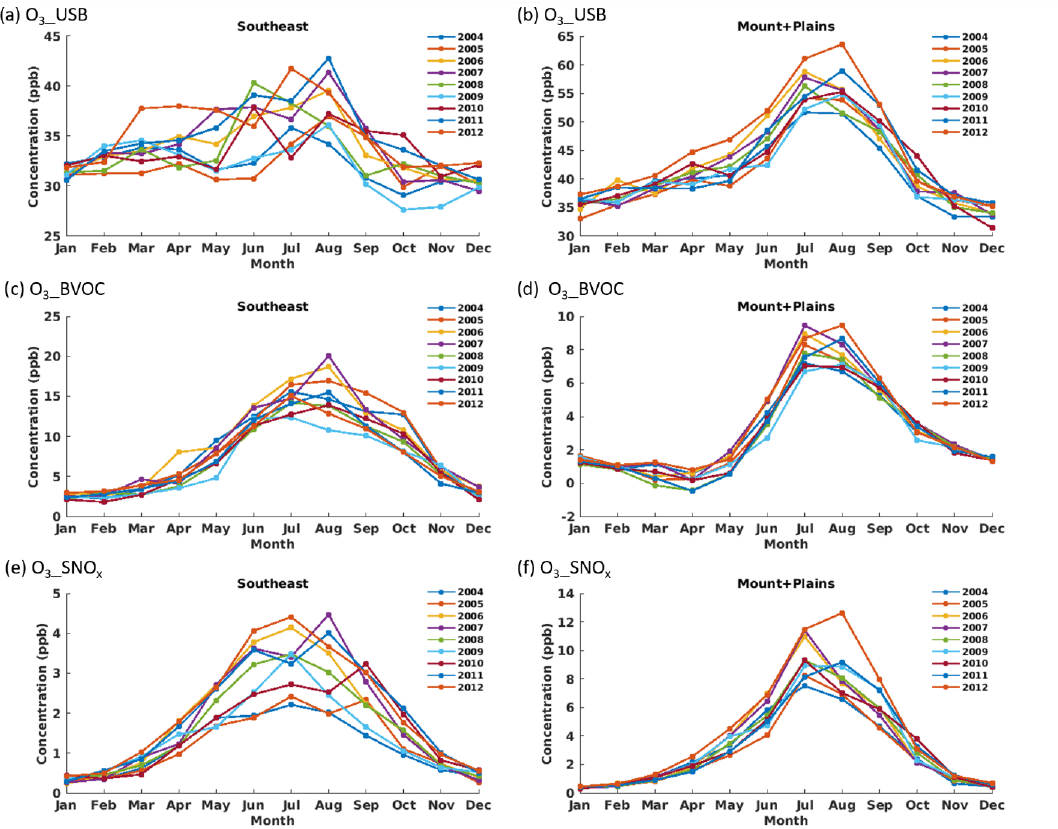
Figure 7. Monthly average MDA8 O 3 _USB (a, b) , O 3 _BVOC (c, d) , and O 3 _SNO x (e, f) concentrations in the Southeast (a, c, e) and Mountains and Plains (b, d, f) regions. Colored lines denote individual years.